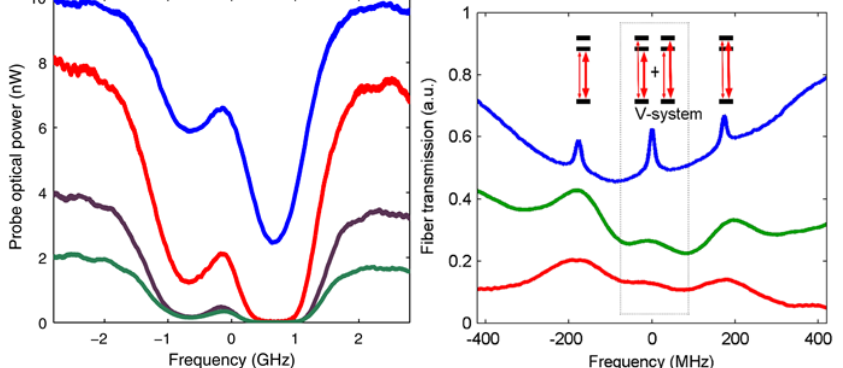
Figure 9. ( Left ) Transmission spectrum for a nanofiber in a vapor cell for increasing probe powers (2, 4, 8, and 10 nW) for the Rb D transition; ( Right ) Saturated absorption 2 spectrum with cross-polarized pump and probe beams for a Rb vapor cell (upper, blue) and a Rb nanofiber system (middle, green and lower, red) for the D1 manifold of 85 Rb. The two side peaks correspond to the Doppler-free F = 3 → F’ = 2 and F = 3 → F’ = 3 hyperfine transitions. The center peak represents a V-system EIT signal. Reprinted with permission from [77]. Copyright 2008 American Physical